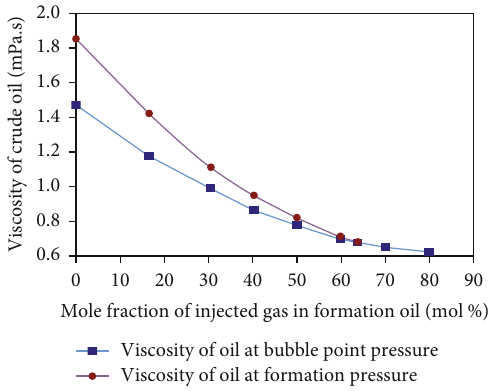
Figure 4: Curves of viscosity of formation oil versus CO